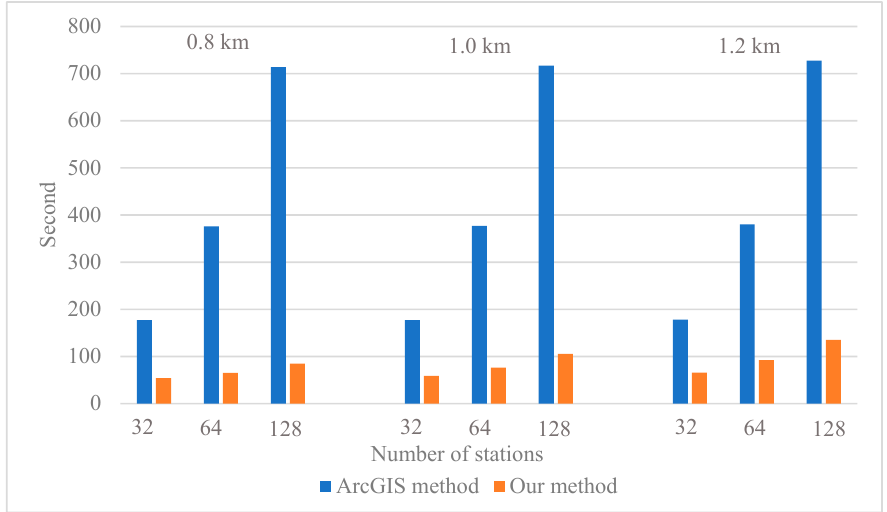
Figure 12. Running times of the ArcGIS method and our method under nine different experimental settings.